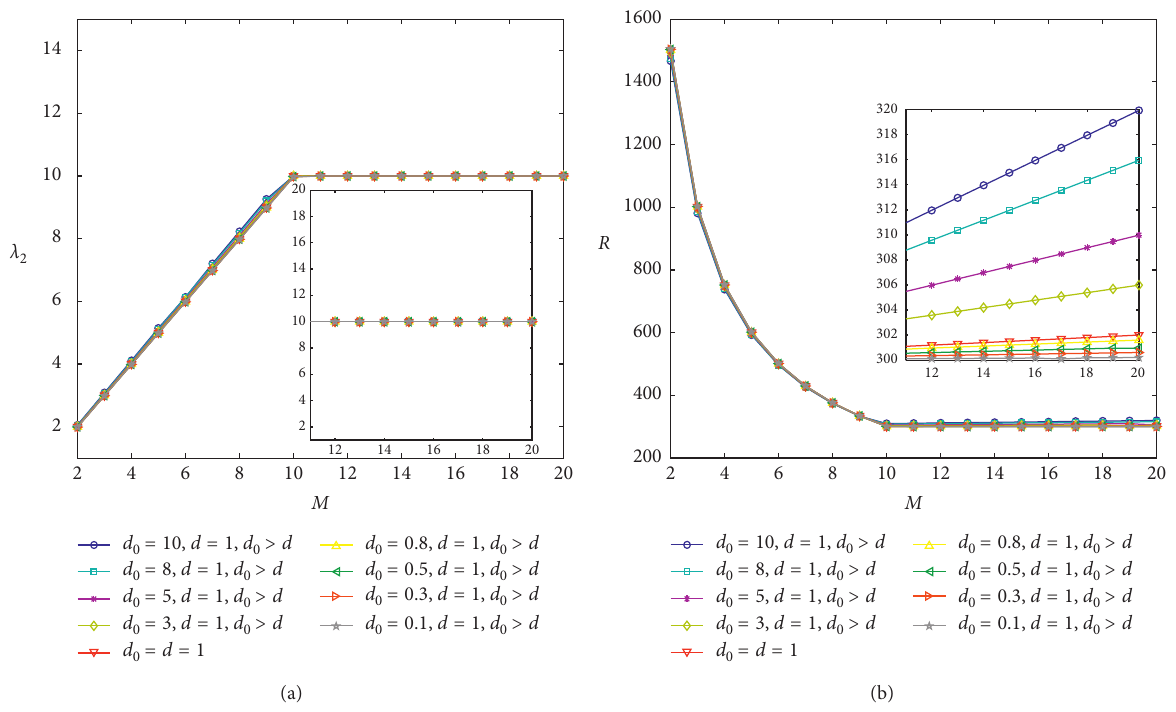
Figure 8: The synchronizability of multilayer star networks vs . varying the number of the layers M ( N � 100, a � 10, and d � 1). (a) λ respect to varying M for different d 0 . (b) R with respect to varying M for different d 0 .